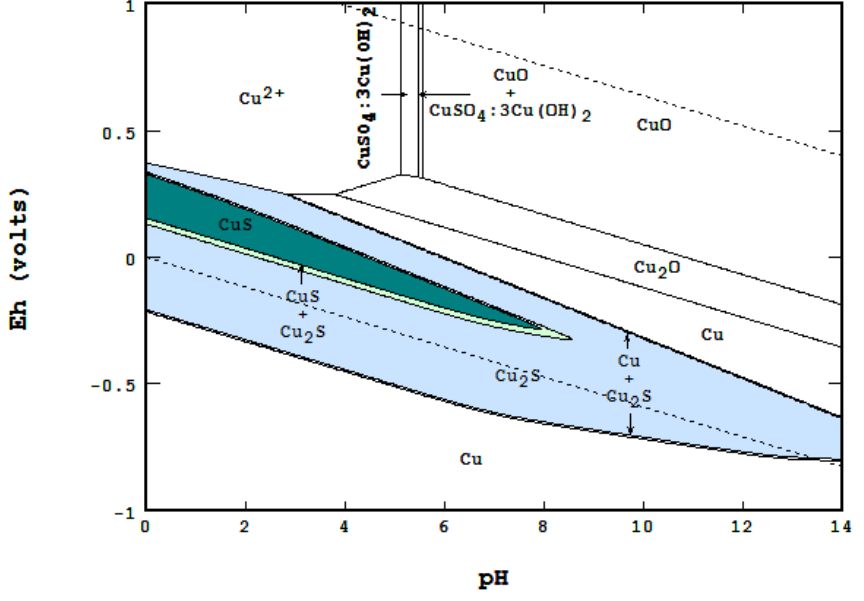
Figure 12. Mass-balanced Eh-pH diagram for the Cu–S–water system with copper slightly in deficit. Σ Cu = 0.001 M and Σ S = 0.0011